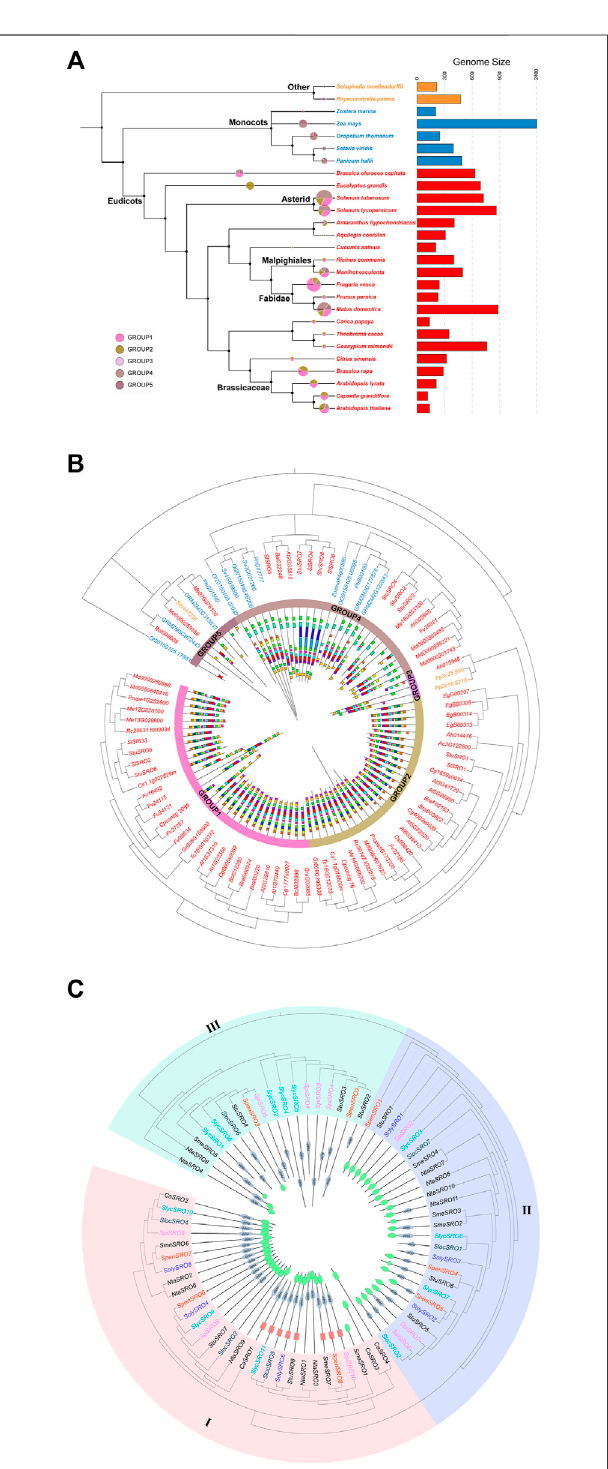
FIGURE 1 | the subgroups to which they belong. (B) Phylogenetic trees were constructed for 93 SRO genes using the NJ method. Different colors represent species with different taxonomic characteristics. Gene structure and conserved motif were peformed inside the phylogenetic tree. (C) Phylogenetic tree of the SRO family in Solanaceae. The phylogenetic tree was FIGURE 1 | Comparison of the SRO family in plants. (A) Evolutionary constructed using the NJ method. The different coloured SRO genes were relationships and number of SRO families in multiple species, with species derived from different tomato species, and the conserved structural domains colours representing their Taxonomic characteristics and the size and colour of the corresponding SRO genes are shown inside the evolutionary tree, with of the sectors representing the number of SRO family in the species and theWWEstructuraldomaininred,theRSTstructuraldomainingreen,andthe ( Continued ) PARP structural domain in